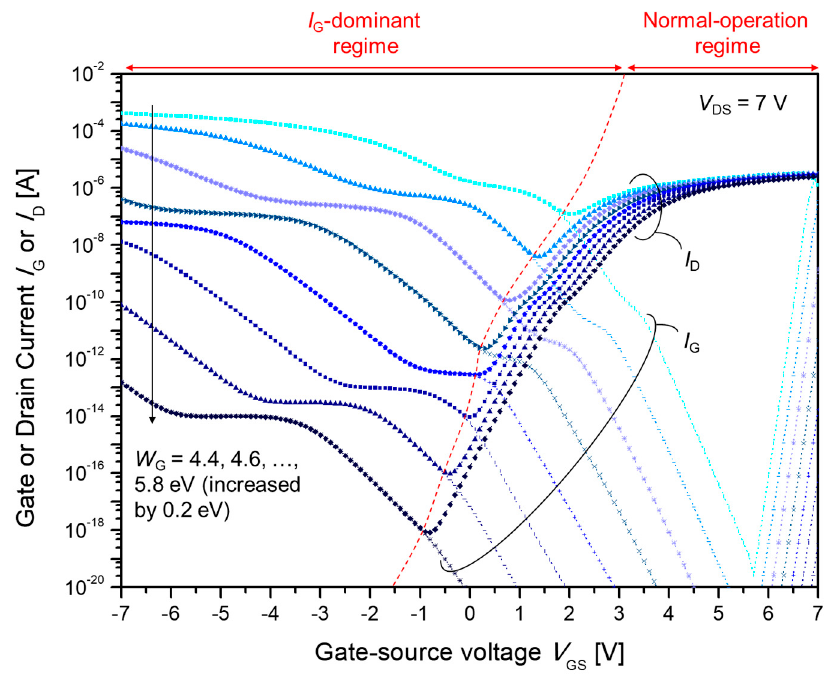
Figure 2. Simulated gate current, I G , and drain current, I D for various gate work functions W G . W G was varied from 4.4 to 5.8 eV by 0.2 eV. An I G -dominant region is observed for the gate voltages smaller than the on voltage V GS < V on .